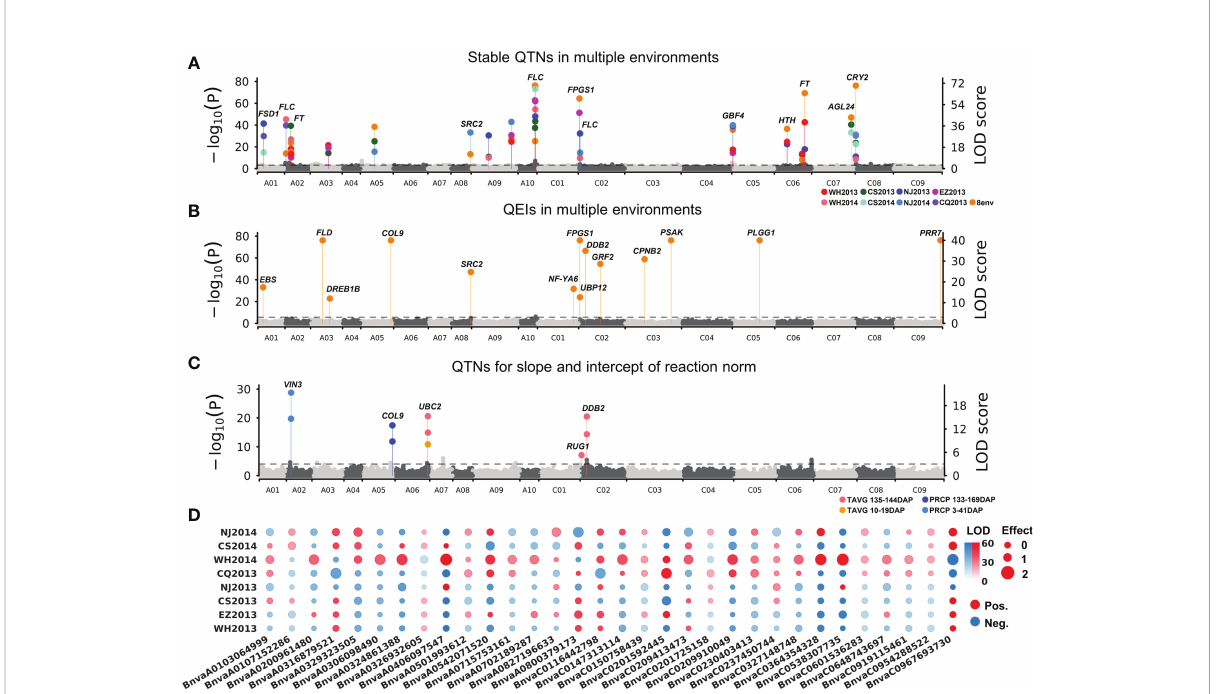
FIGURE 2 Manhattan plots for fl owering time of 490 B napus accessions. (A) Nineteen stable main-effect QTNs and their candidate genes for fl owering time in eight single environment analyses and multiple environments joint analysis. (B) QTN-by-environment interactions (QEIs) and their candidate genes for fl owering time in multiple environments joint analysis. (C) Ten main-effect QTNs for slope and intercept of reaction norm for fl owering-time-related climatic indexes. (D) Additive-by-environment interaction effects of 32 QEIs in eight environments. The size of dot: absolute value of additive-by-environment interaction effect. Red/blue dot: positive/blue value. WH2013, Wuhan in 2013; WH2014, Wuhan in 2014; CS2013, Changsha in 2013; CS2014, Changsha in 2014; NJ2013, Nanjing in 2013; NJ2014, Nanjing in 2014; CQ2013, Chongqing in 2013; EZ2013, Ezhou in